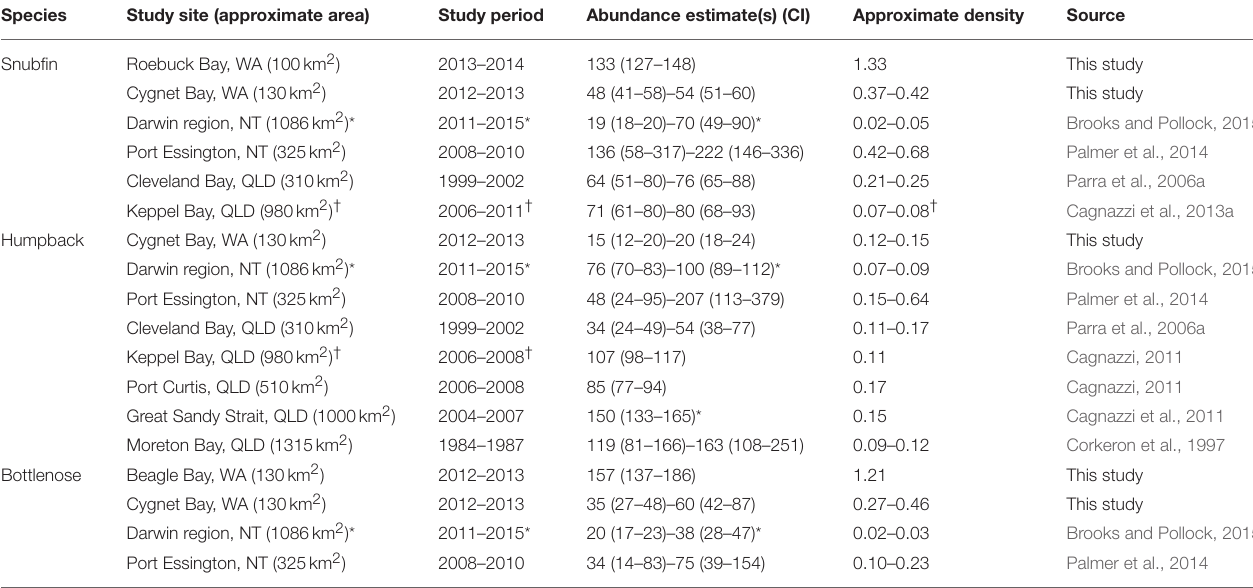
TABLE 1 | Capture-recapture abundance estimates of snubfin, humpback, and bottlenose dolphins in Western Australia (WA), Northern Territory (NT), and Queensland (QLD).